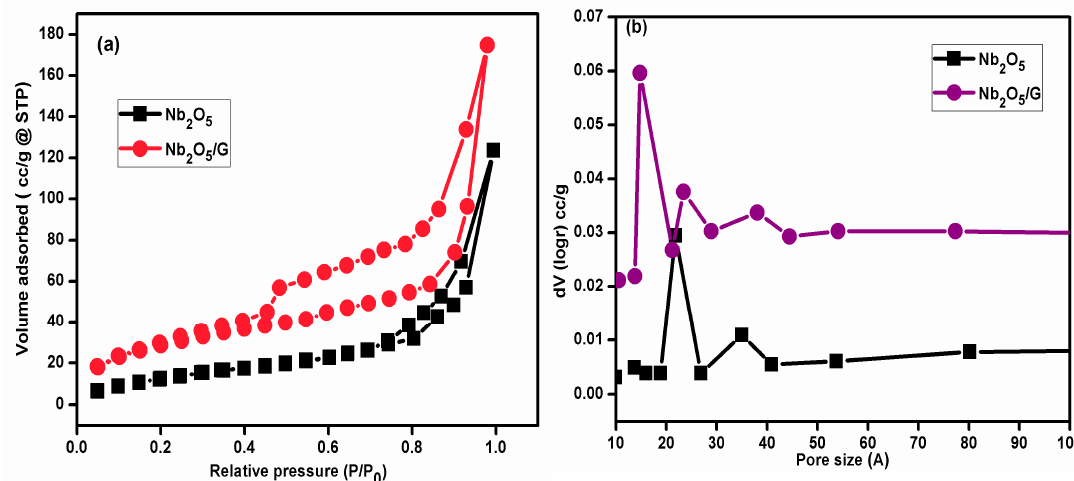
Figure 8. ( a ) Characteristics of N 2 adsorption-desorption isotherm plots; and ( b ) BJH pore size distribution of Nb 2 O 5 and Nb 2 O 5 /G nanocomposite.